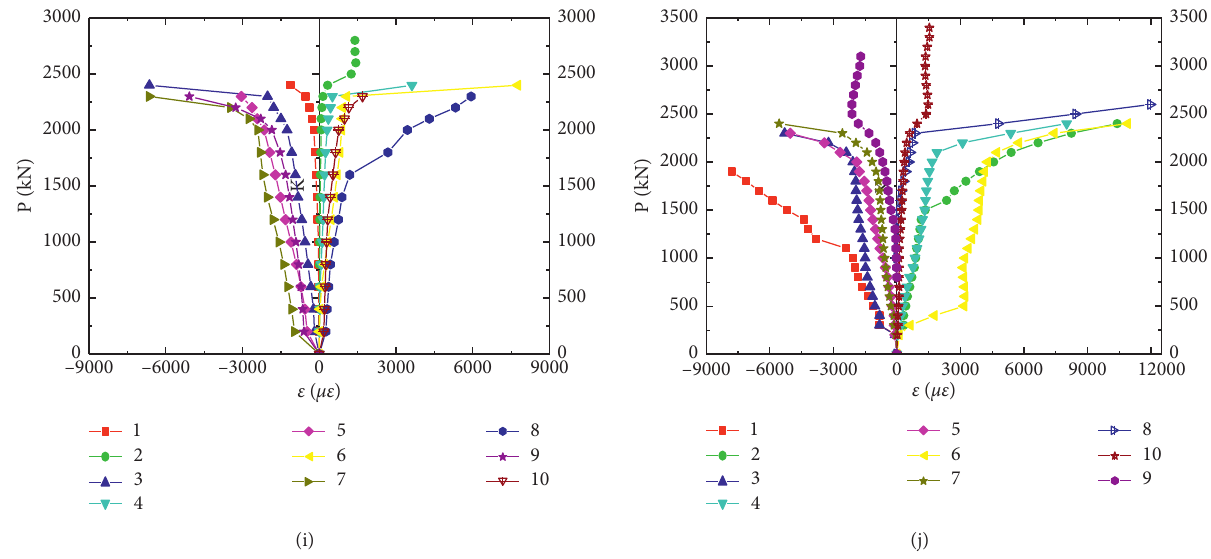
Figure 13: Load-strain curves of some specimens at 300 and 600. (a) 4 mm-300 ° C-1 hour. (b) 4mm-300 ° C-1.5 hours. (c) 4 mm-600 ° C-1 hour. (d) 4 mm-600 ° C-2 hours. (e) 5mm-300 ° C-1 hour. (f) 5mm-300 ° C-2 hours. (g) 5mm-600 ° C-1 hour. (h) 6 mm-600 ° C-1 hour. (i)